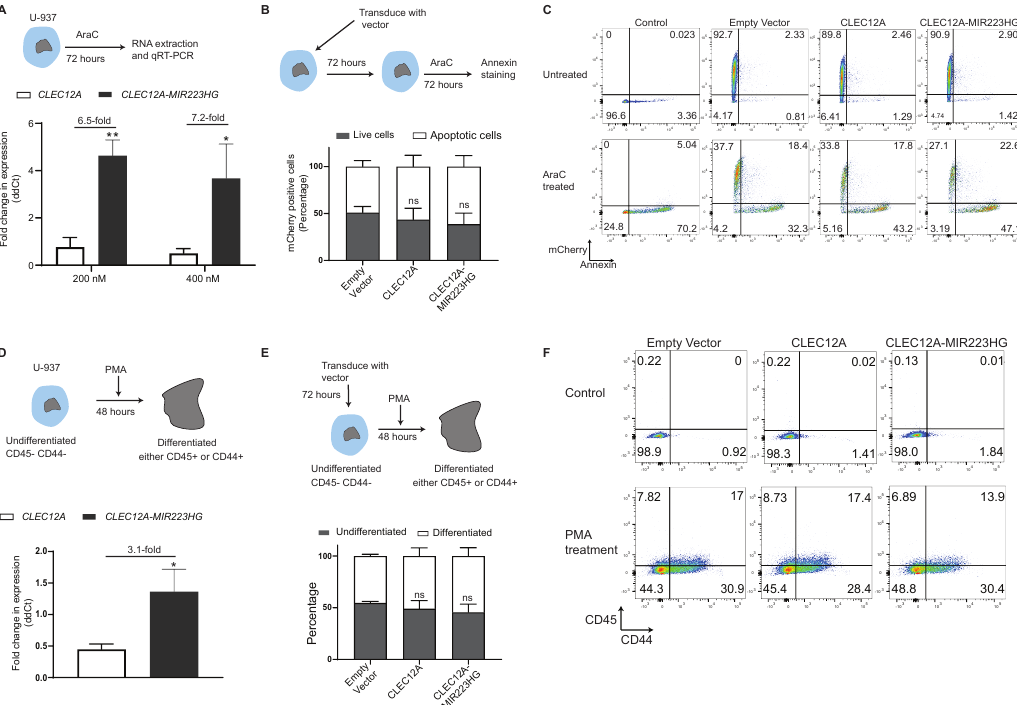
Figure 4. Biological roles of CLEC12A-MIR223HG . ( A ) Fold change in the expression of CLEC12A and CLEC12A-MIR223HG in U-937 cells treated with two different doses of cytarabine (AraC) measured by qRT-PCR. ( B ) Percentage of apoptotic cells (Annexin V-positive cells) after the treatment of U-937 cells overexpressing CLEC12A or CLEC12A-MIR223HG with cytarabine. ( C ) Representative flow cytometry plots depicting percentage of apoptotic U-937 cells overexpressing either CLEC12A or CLEC12A-MIR223HG after AraC treatment. X -axis: Annexin V, Y -axis: mCherry (depicting transduction efficiency). ( D ) Fold change in the expression of CLEC12A and CLEC12A-MIR223HG during the differentiation of U-937 monocytes induced by phorbol 12-myristate 13-acetate (PMA) treatment (measured by qRT-PCR). ( E ) Percentage of either CD45+ or CD44+ cells after the treatment of U-937 cells overexpressing CLEC12A or CLEC12A-MIR223HG with PMA. ( F ) Representative flow cytometry plots depicting the percentage of either or CD44 ( x -axis) or CD45 ( y -axis) in PMA-treated U-937 monocytes overexpressing CLEC12A or CLEC12A-MIR223HG ( n > 3, * p < 0.05, ** p <